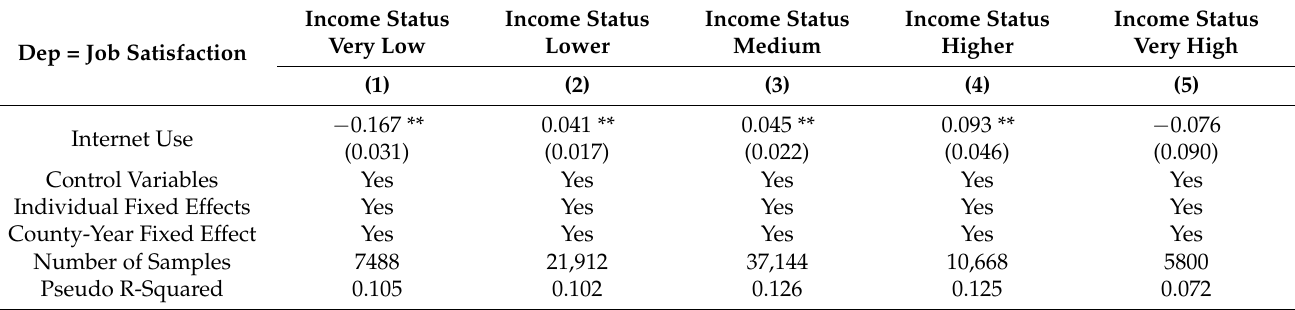
Table 4. Income Status Heterogeneity.